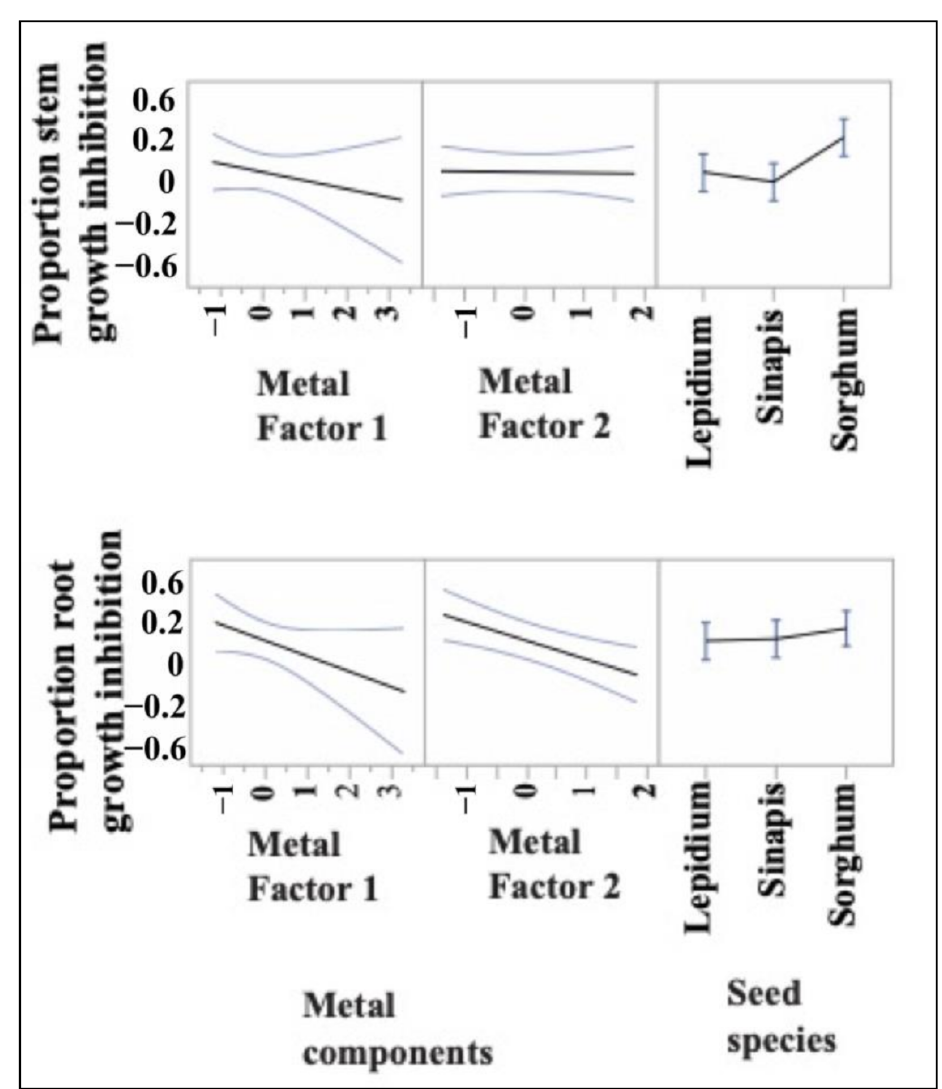
Figure 4. Prediction profiles from ANOVA showing the effects of metal components 1 and 2 (from factor analysis) on the growth inhibitions of the bioindicator species Lepidium sativum , Sinapis alba and Sorghum saccharatum . The blue-lined area in each profile represents the 95% confidence interval for the prediction of the response variable. The profiler was set to metal component 1 at 1.0 and metal component 2 at 0.75 in case of root and stem growth